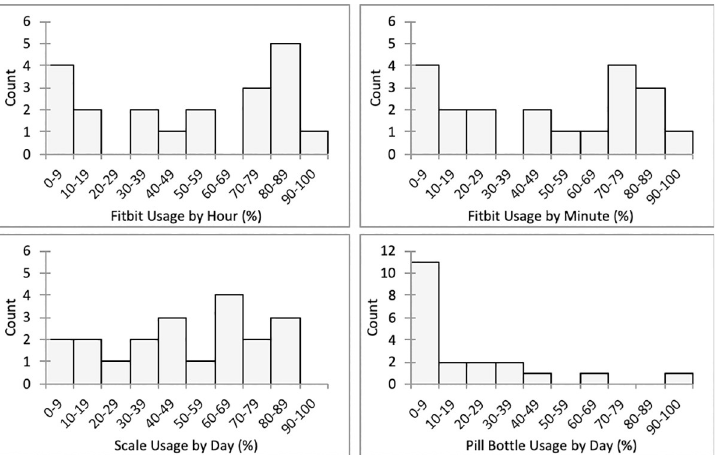
Fig 2. Histograms of activity tracker, bathroom scale, and smart pill bottle usage. Median (IQR) usage percentages were 79.1% (27.1%-90.6), 75.4% (23.4%-84.9%), 59.7% (24.6%-79.4%), and 2.8% (0.0%-54.3%) for HR-hour, HR- minute, bathroom scale, and smart pill bottle,